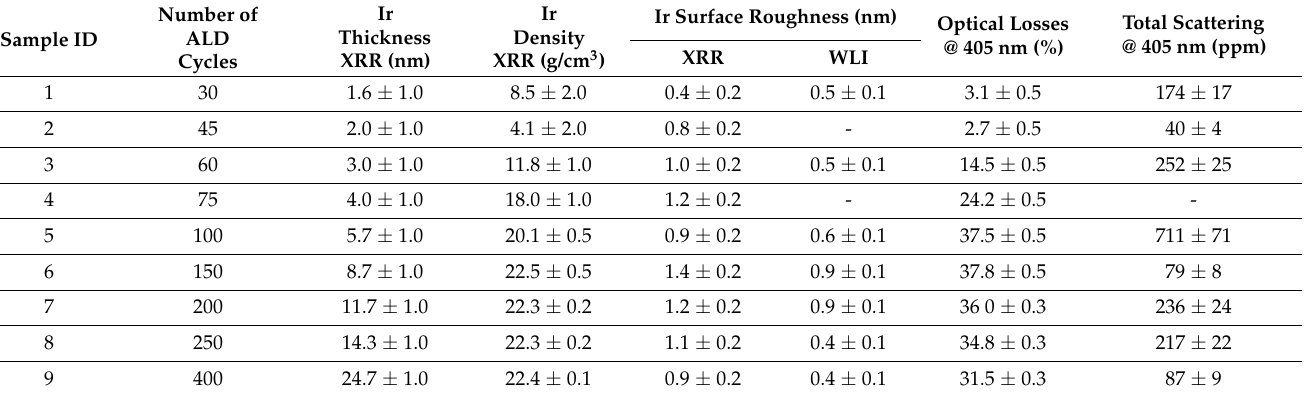
Figure 1. ( a ) Reflectance, ( b ) transmittance, and ( c ) optical losses of iridium (Ir) coatings deposited on fused silica (FS) using different atomic layer deposition (ALD) cycles. Additionally, top-view scanning electron microscopy (SEM) images are shown for selected coatings with 60 and 100 ALD cycles in which Ir appears bright on the dark-appearing FS surface. Table 1. Properties of Ir ALD coatings deposited on FS. The effective Ir layer thickness and density were analyzed using X-ray reflectometry (XRR), white light interferometry (WLI), and XRR for surface